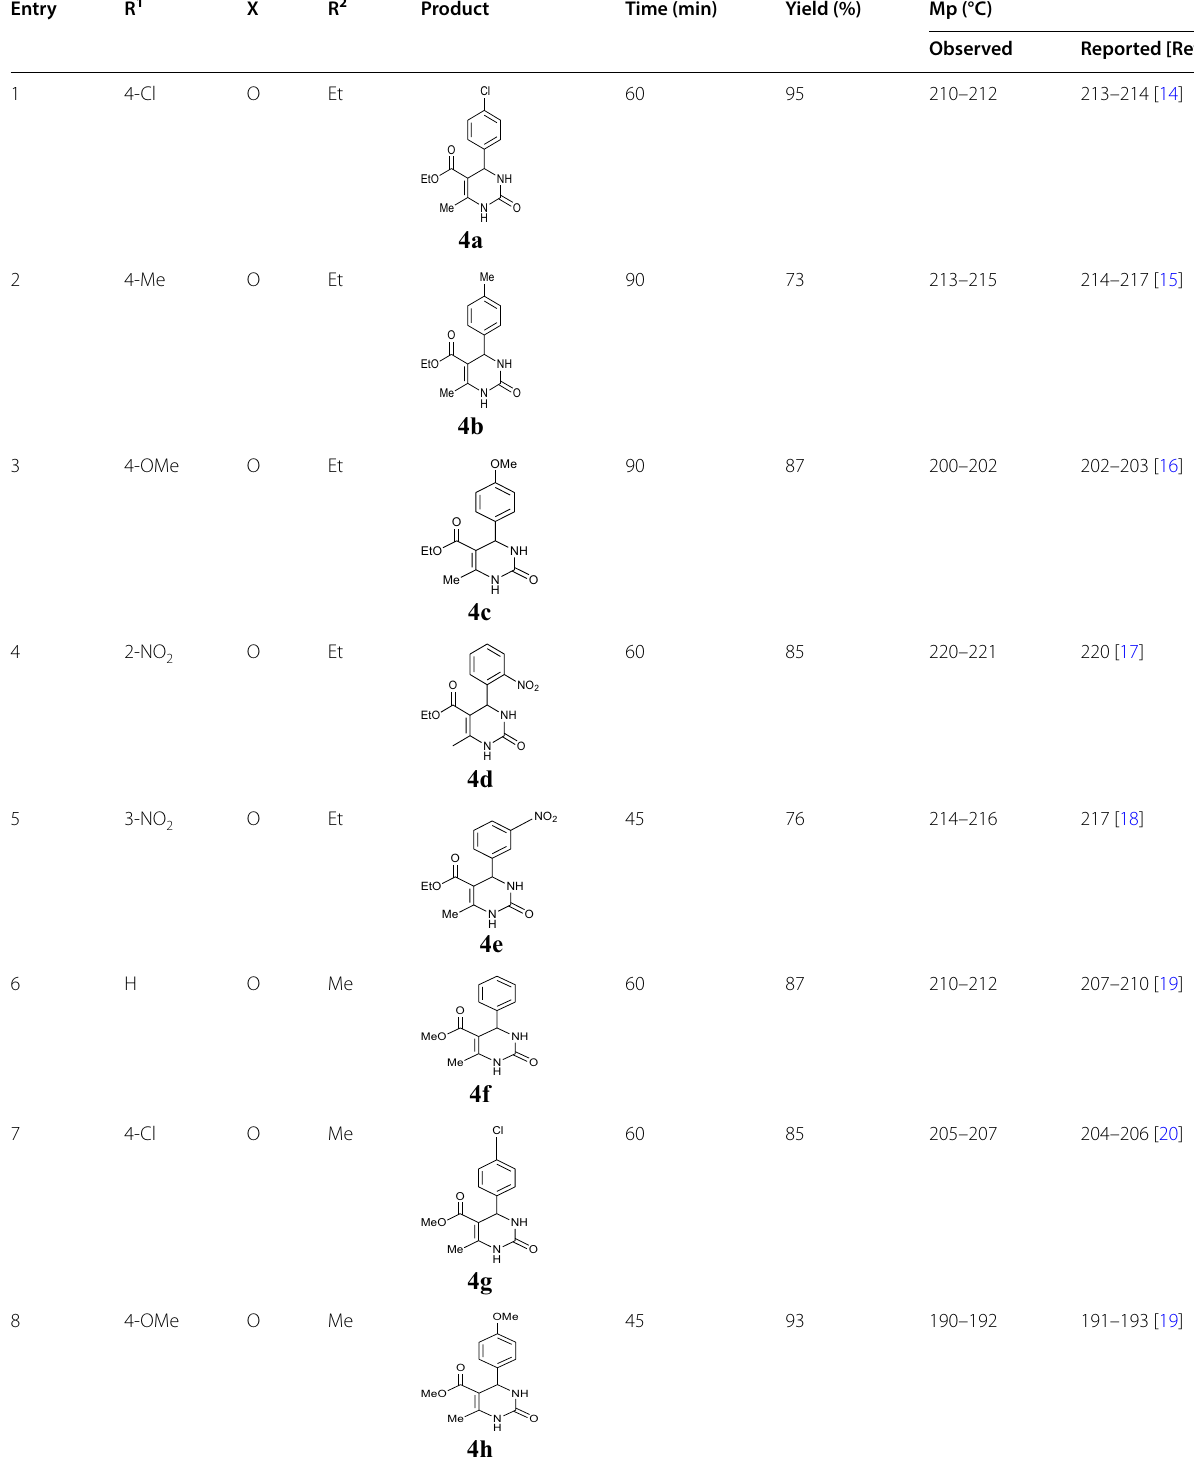
Table 2 Synthesis of pyrimidine derivatives under optimum reaction